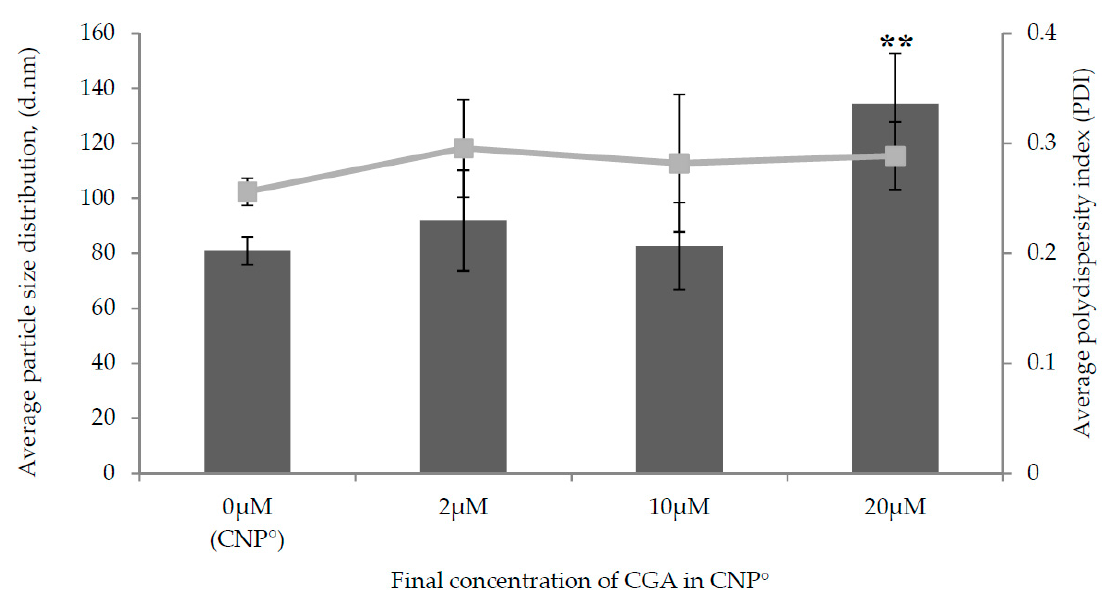
Figure 4. Effect of different final concentrations of CGA on average particle size distribution (nm) and polydispersity index, (PDI) of CNP°. The average particle size distribution is illustrated in bar graph and PDI is illustrated in line graph. Error bars represent the SD of three independent replicates of the experiment. * shows degree of significant difference, P < 0.0086 compared to control, CNP°.